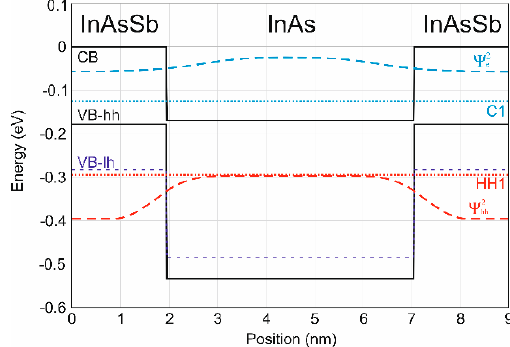
Figure 3. Calculated band structure for the InAs (5.096 nm)/InAs 0.62 Sb 0.38 (1.94 nm) T2SL with periodic boundary conditions at 230